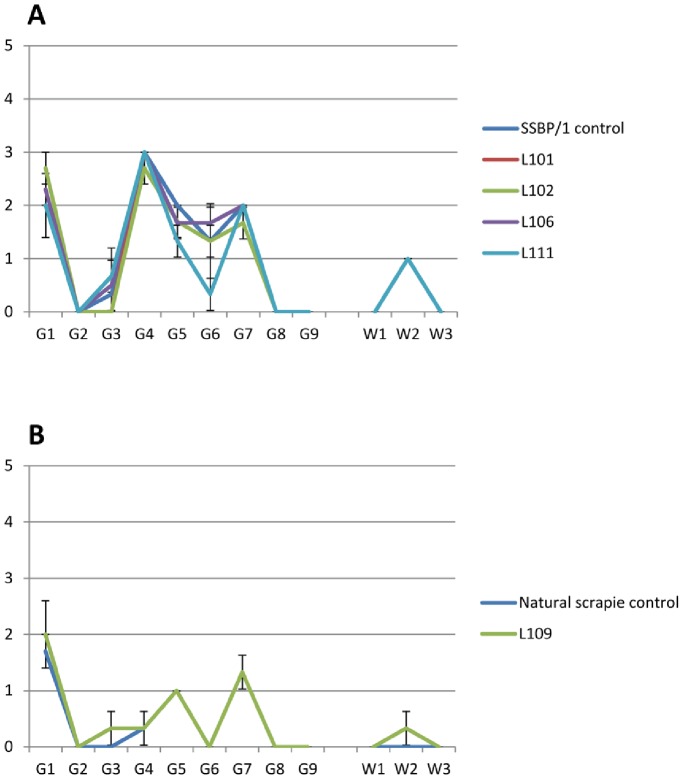
Placental tissue and PrPSc.Immunostaining for PrPSc using BG4 antibody in placental tissue (cotyledon) from recipient ewe R46 (x 40).